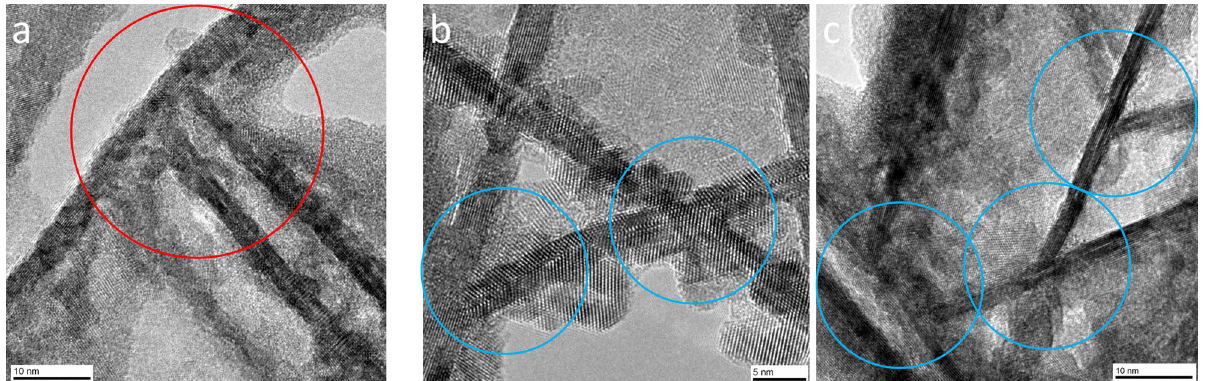
Figure 4. ( a ) High-resolution plane-observed TEM image of the SnO 2 nanosheets connected with a branch angle of 90° (type I). ( b , c ) High-resolution plane-observed TEM image of the SnO 2 nanosheets connected with a branch angle of 40°–50° (type SnO 2 , and they connect to form the branch angle of the type II (46.48°) connection. The branch angle of the type II (46.48°) connection was analyzed with a crystal structure analysis program ReciPro (ver. 4.283). The crystal system, laue group, space group, lattice constant of the a -axis, and lattice con- stant of the c -axis were tetragonal, 4/ mmm , P 4 2 / mnm , 4.737 Å, and 3.185 Å, respectively. The angle between the (101) and (110) crystal planes was 66.76°. The calculated branch angle of the type II connection was 46.48